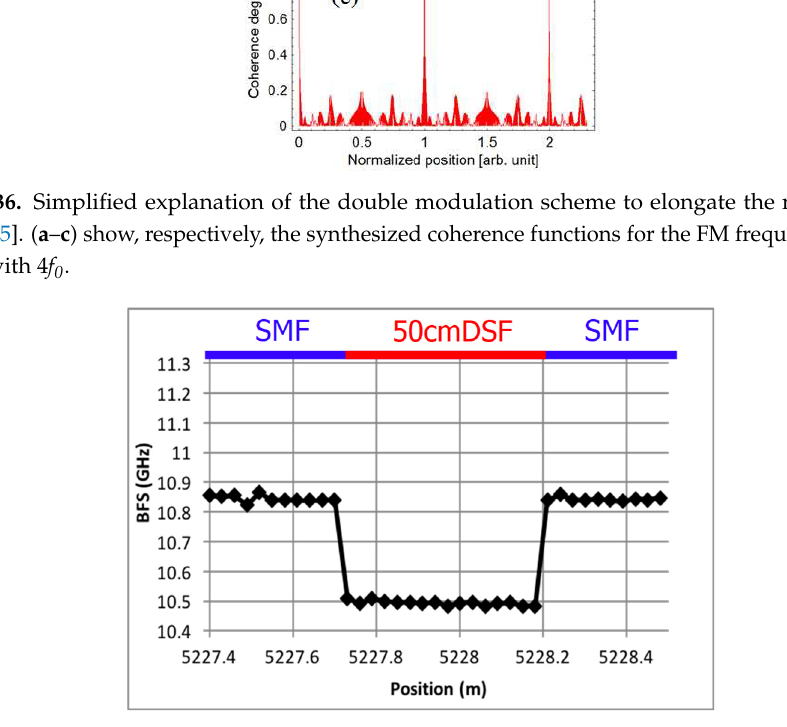
Figure 36. Simplified explanation of the double modulation scheme to elongate the measurement range [55]. ( a – c ) show, respectively, the synthesized coherence functions for the FM frequency of f 0 , 4 f 0 , and f 0 with 4 f 0 .